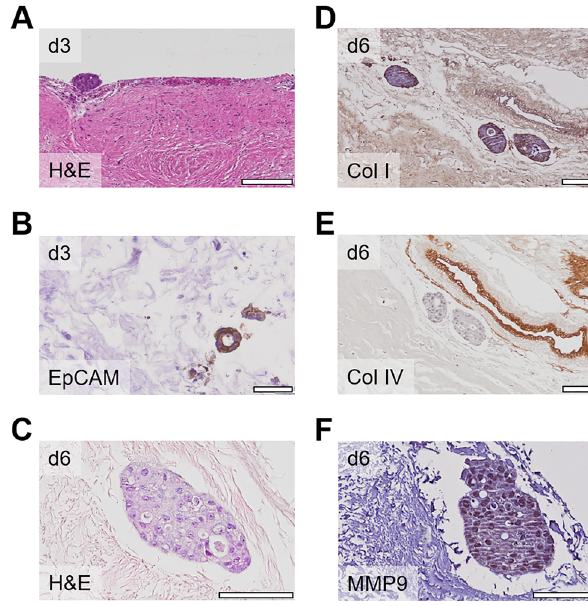
Figure 4: Modeling peritoneal metastasis using patient-derived